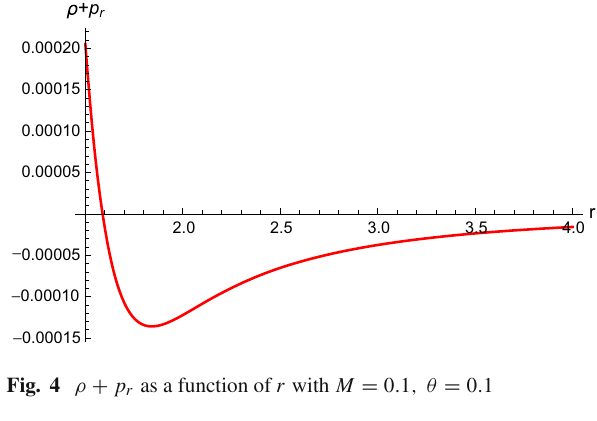
Fig. 4 ρ + p r as a function of r with M = 0 . 1 , θ = 0 . 1